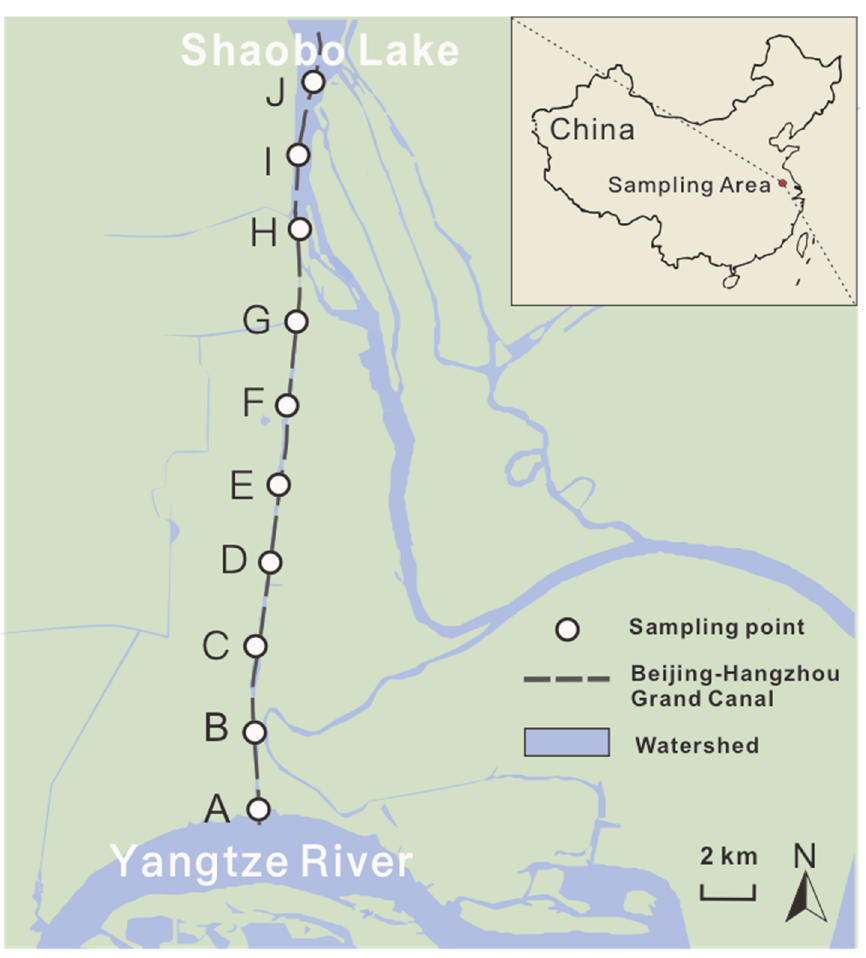
Figure 1. Locations of the sampling sites along the Grand